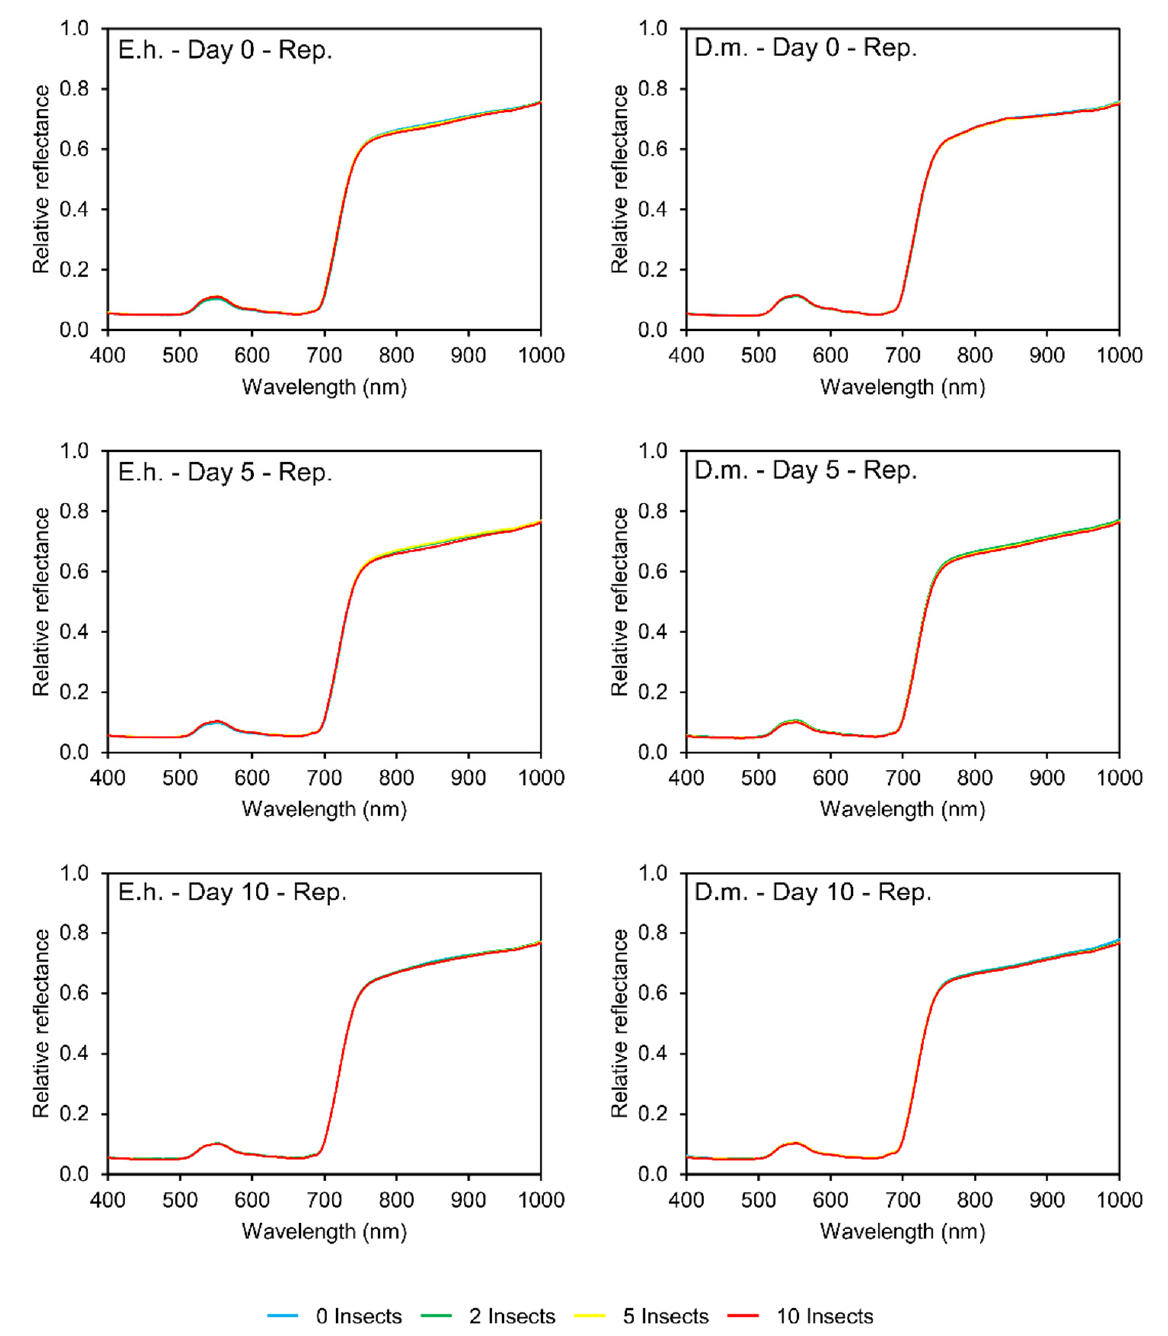
Figure 2. Spectral curves (400–1000 nm) of soybean leaves (0, 5, and 10 days after infestation) under different levels of stinkbug infestation ( left column — Euschistus heros (E.h.); right column — Diceraeus melacanthus (D.m.)).